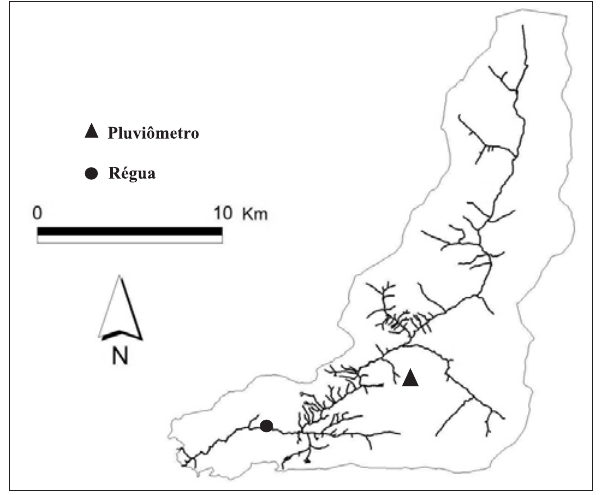
Figura 1. Layout da bacia hidrográfica do ribeirão Pipiripau, mostrando as localizações do pluviômetro e da régua